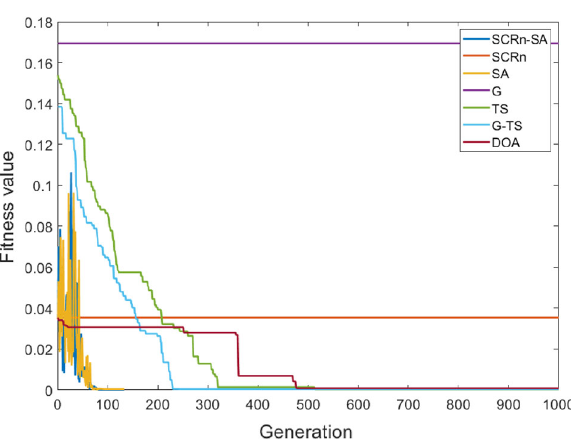
Fig. 13 Convergence curve for D 2 Fig. 14 Convergence curve for D